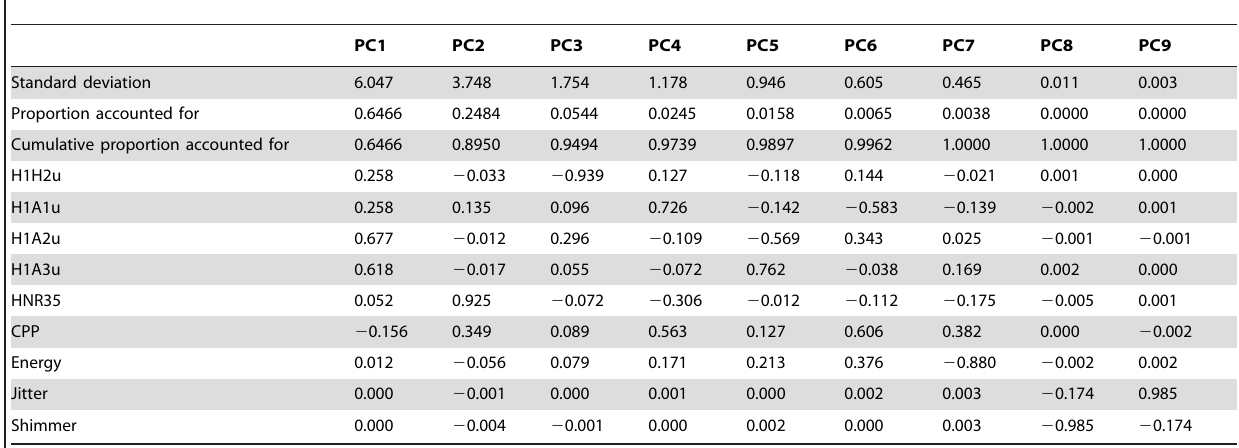
Table 3. The cumulative proportion of variance accounted for and loadings from the PCA of voice quality measures for female voices.